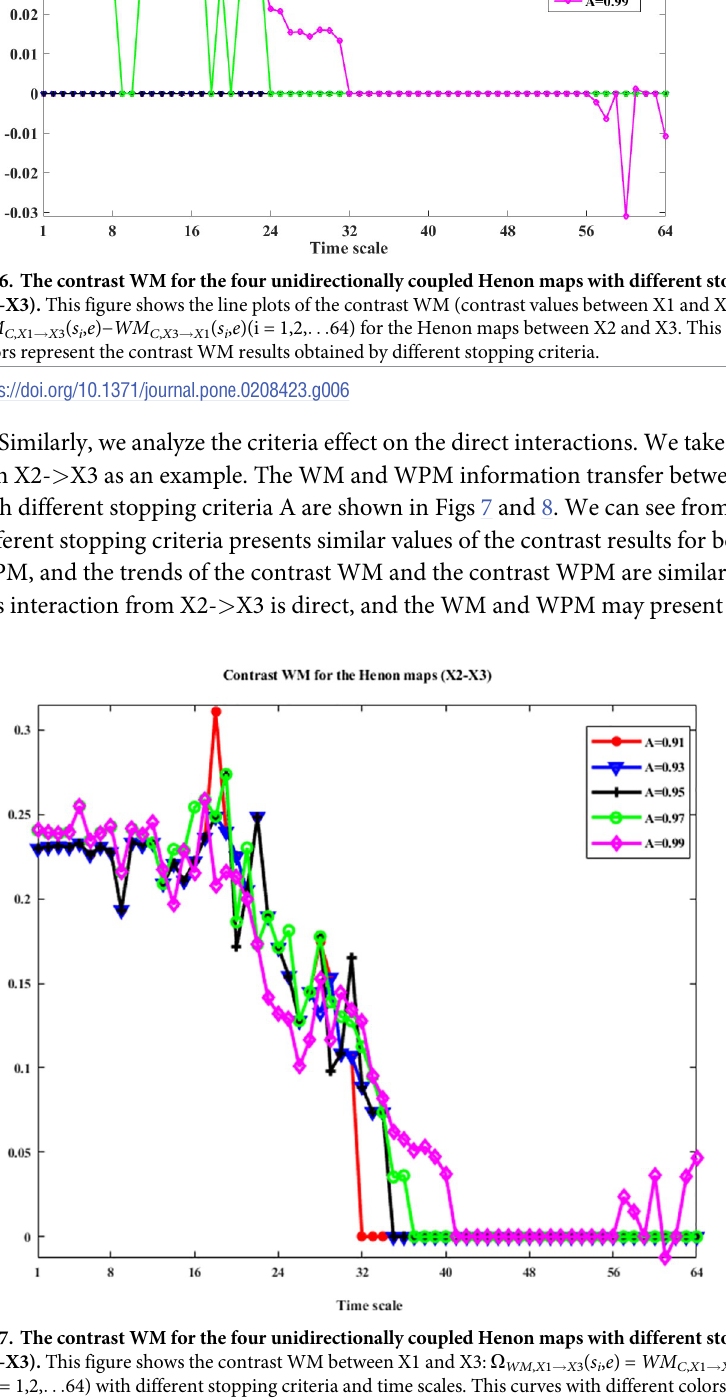
( s , e ) = WM , X 1 ! X 3 i